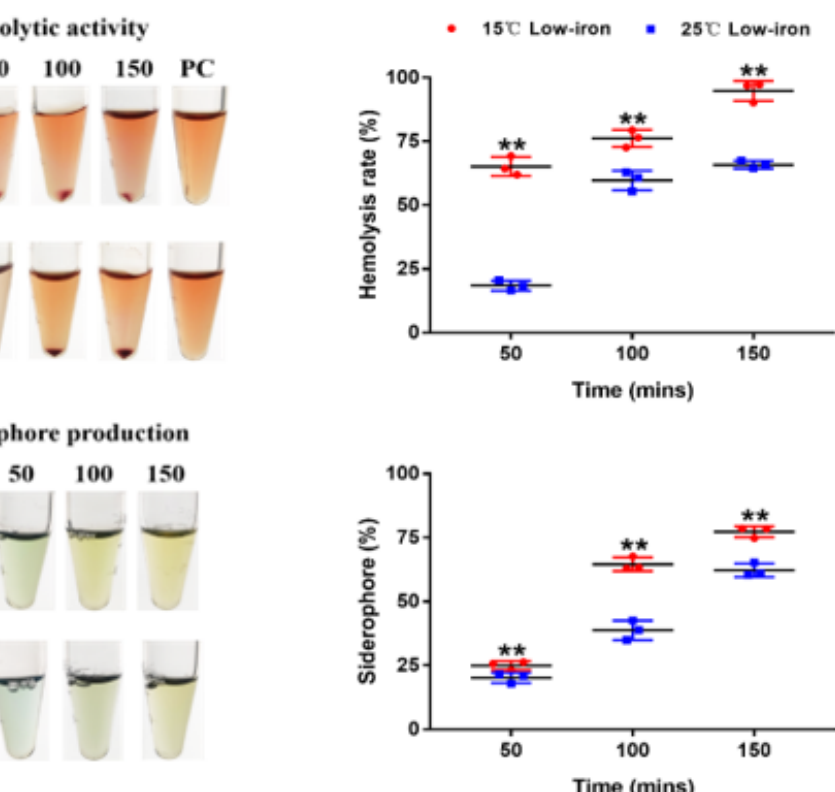
Figure 7. Effect of temperature on hemolytic activity and siderophore production of SbA1-1. ( A ) Hemolytic activity (left) and siderophore production (right) of SbA1-1 at low (15 °C) and high (25 °C) temperatures. Bar = 1 cm. ( B ) Quantification of hemolytic activity and siderophore production by SbA1-1 at different temperatures. Tubes show the color change of hemolytic and CAS reaction at different time points under 15 °C and 25 °C temperature conditions. The corresponding scatter plots show the value changes. ** p < 0.01.